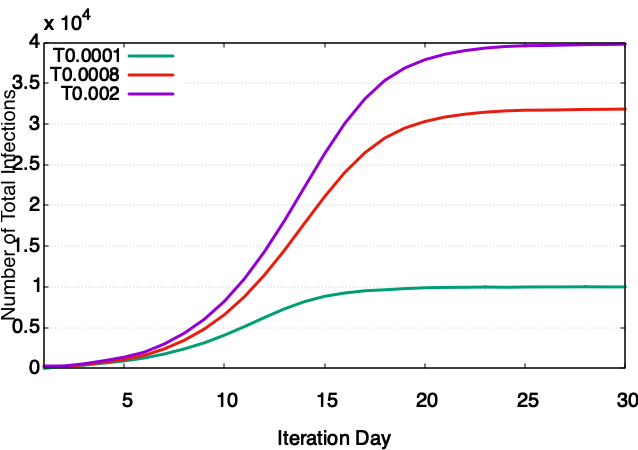
Figure 8. SIM-D showing the effect of transmissibility on the number of total infections. At very small values of transmissibility (0.0001), the attack rate is 10%. At transmissibility of 0.0008, the attack rate is 33%. At transmissibility of 0.002, the attack rate is 40%.